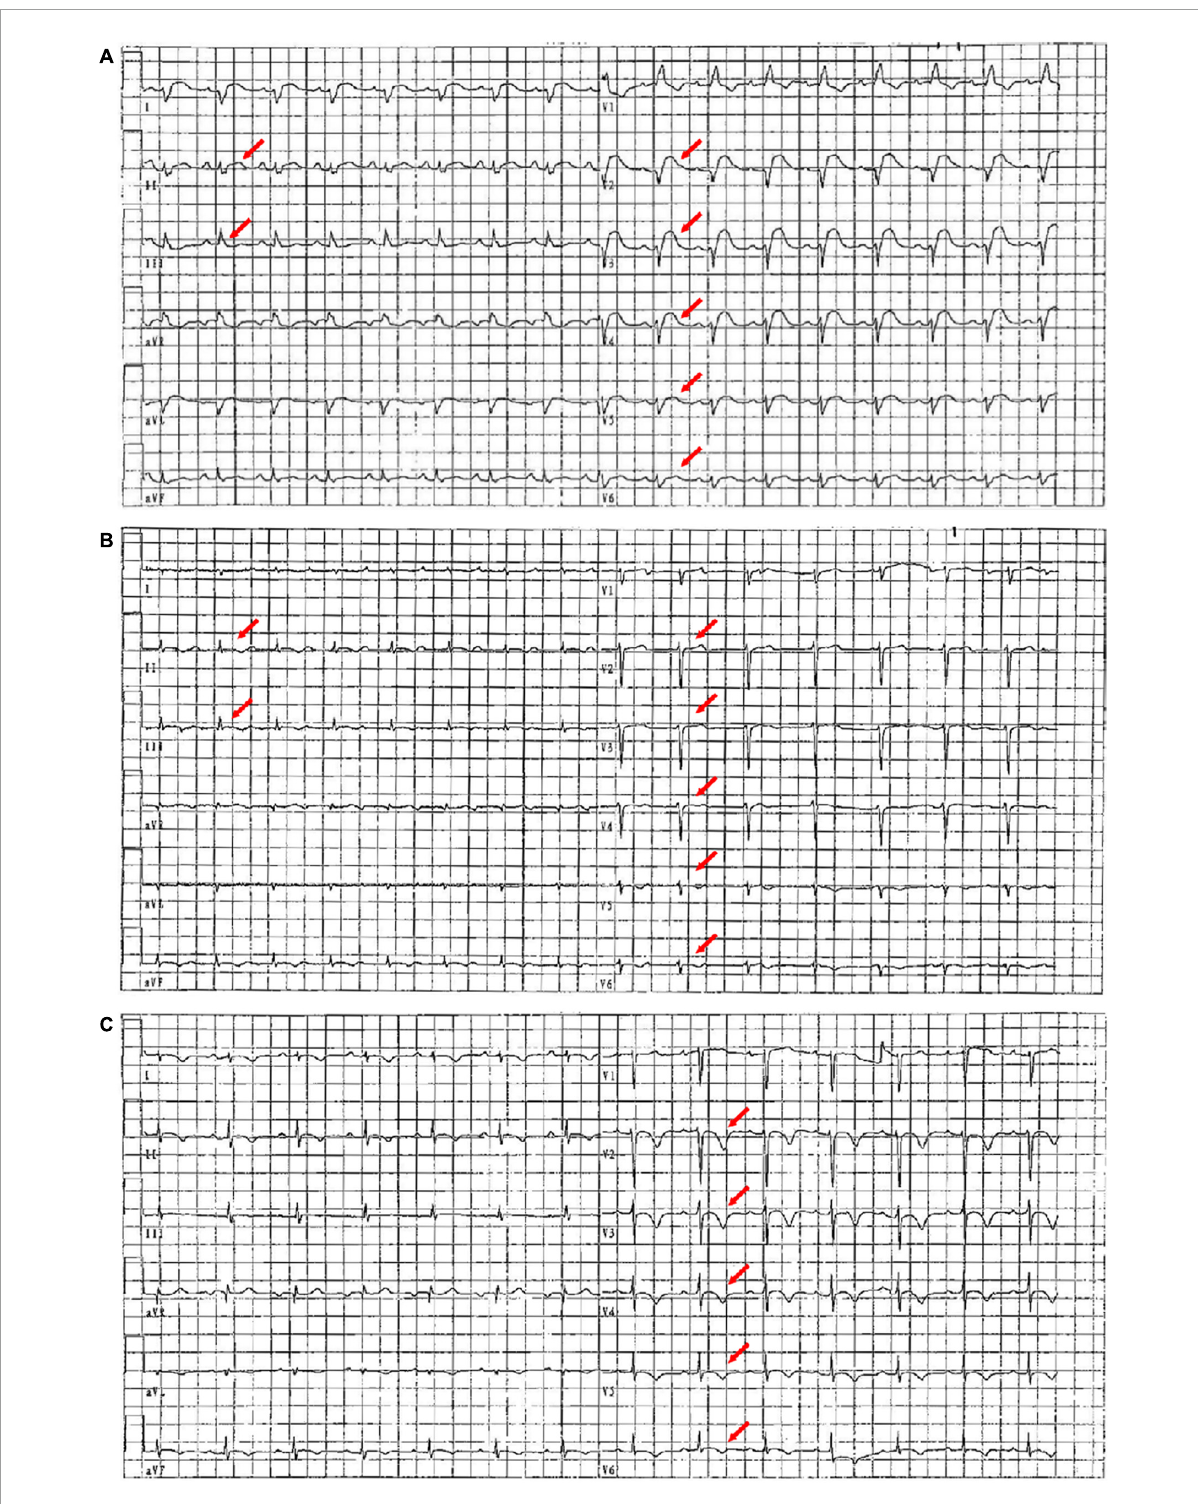
FIGURE1 ECG images on the first day, the seventh day, and the 20th day of admission. (A) On the first day of admission, ECG showed sinus rhythm, right bundle branch block, and diffuse ST-segment elevation (red arrow). (B) On the seventh day of admission, ECG showed sinus rhythm and diffuse ST-segment elevation that improved significantly (red arrow). (C) On the 20th day of admission, ECG showed sinus rhythm with extensive anterior wall T-wave inversion (red